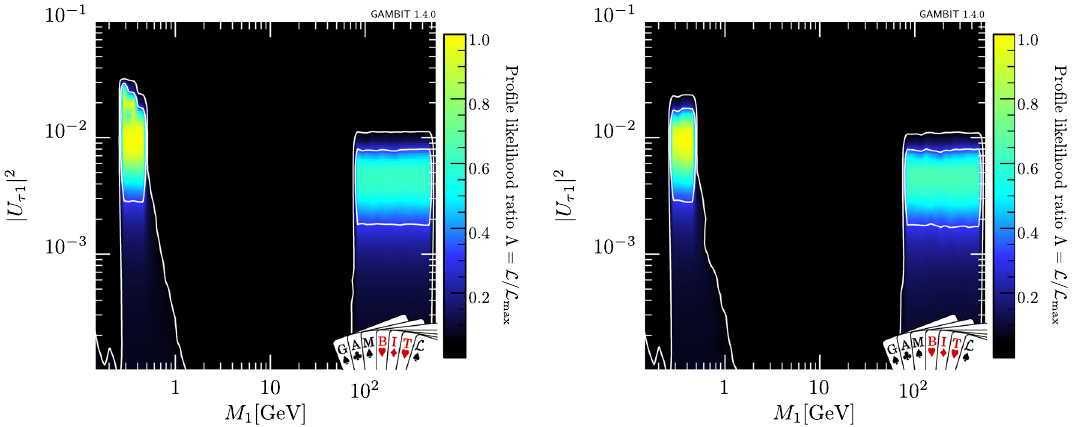
Fig. 14 Profile likelihood in M I vs U 2 τ plane without likelihood cap showing the excesses due to the Γ in v , CKM and R τ constraints, for normal I (left) and inverted hierarchy (right)